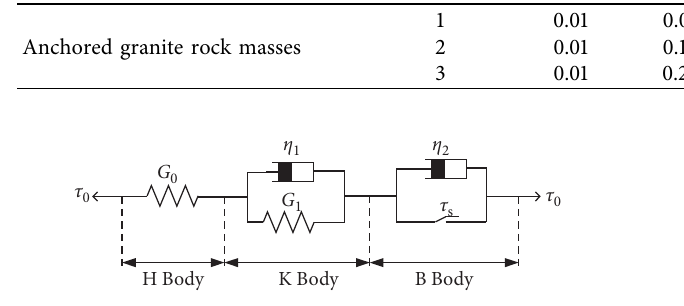
Figure 9: Shear creep model. Figure 10: Model of body E